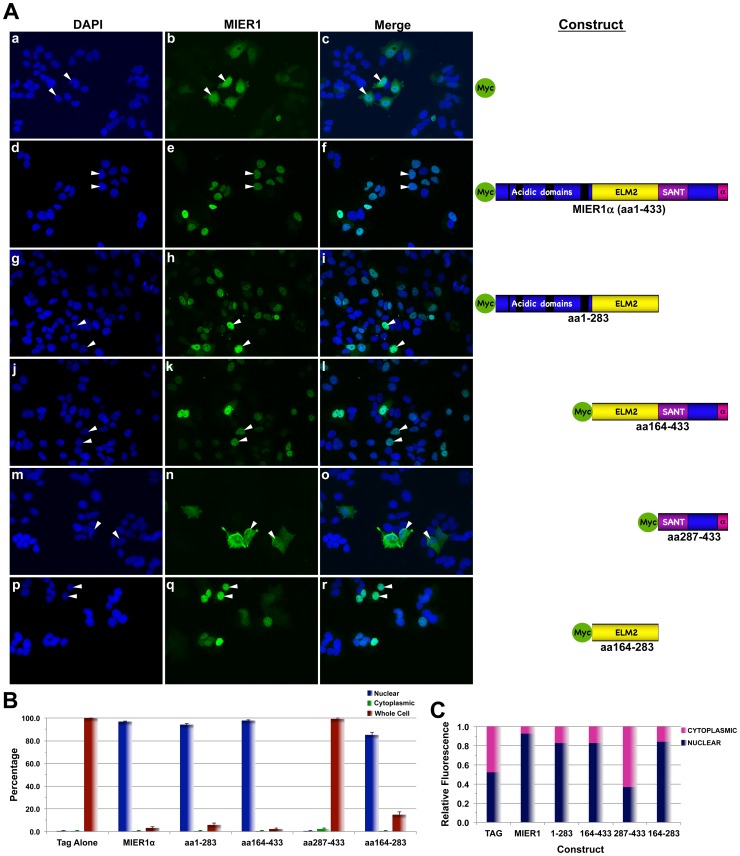
The ELM2 domain is sufficient for nuclear localization of MIER1α.MCF7 cells were transfected with myc-tag empty vector (panels a-c), myc-tagged full-length MIER1α (d-f) or a myc-tagged MIER1α deletion construct containing either the acidic + ELM2 domains (g-i), the ELM2 + SANT + α C-terminus (j-l), the SANT domain + α C-terminus (m-o) or the ELM2 domain alone (p-r). Localization was analyzed by confocal microscopy using DAPI and 9E10 anti-myc tag antibody. (A) Illustrative examples of cells showing stained nuclei and MIER1α localization; arrowheads show examples of nuclei. A schematic, drawn to scale and illustrating the MIER1α domains and constructs used, is shown on the right; the acidic stretches are shown as black bars, the ELM2 domain is in yellow, the SANT domain in purple, the α C-terminus in pink and all remaining sequence in blue. The amino acids (aa) encoded by each construct are indicated. The myc epitope tag is shown in green. (B) Histogram showing the results of 3 independent experiments; random fields were selected and the staining pattern of each cell within the field was scored visually. 220–970 cells were scored for each construct. Plotted is the percentage of cells in each category ± S.D; the percent nuclear for the SANT domain + α C-terminus (aa287-433) construct is significantly less than that for full-length MIER1α (p<0.05). (C) Bar graph showing the intracellular distribution of MIER1α. Pixel values for the nuclear and the cytoplasmic compartments were measured in confocal z-stacks using Image J v1.38; plotted is the proportion of the total signal in each compartment, using measurements from 20–30 cells for each construct. The proportion of the SANT domain + α C-terminus (aa287-433) construct in the nuclear compartment is significantly less than that of full-length MIER1α (p<0.05).